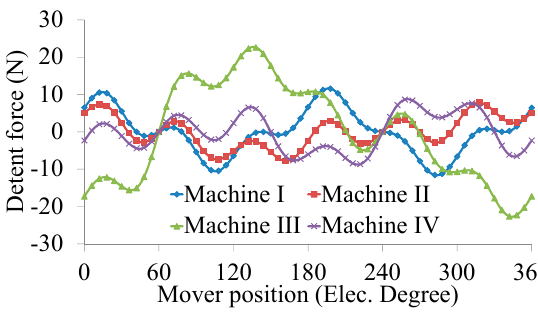
Figure 17. Detent force comparison among four machines.